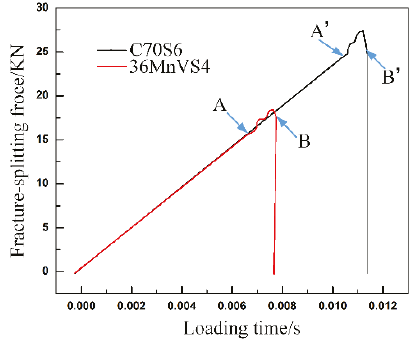
Figure 10. The curve of fracture-split force and time.